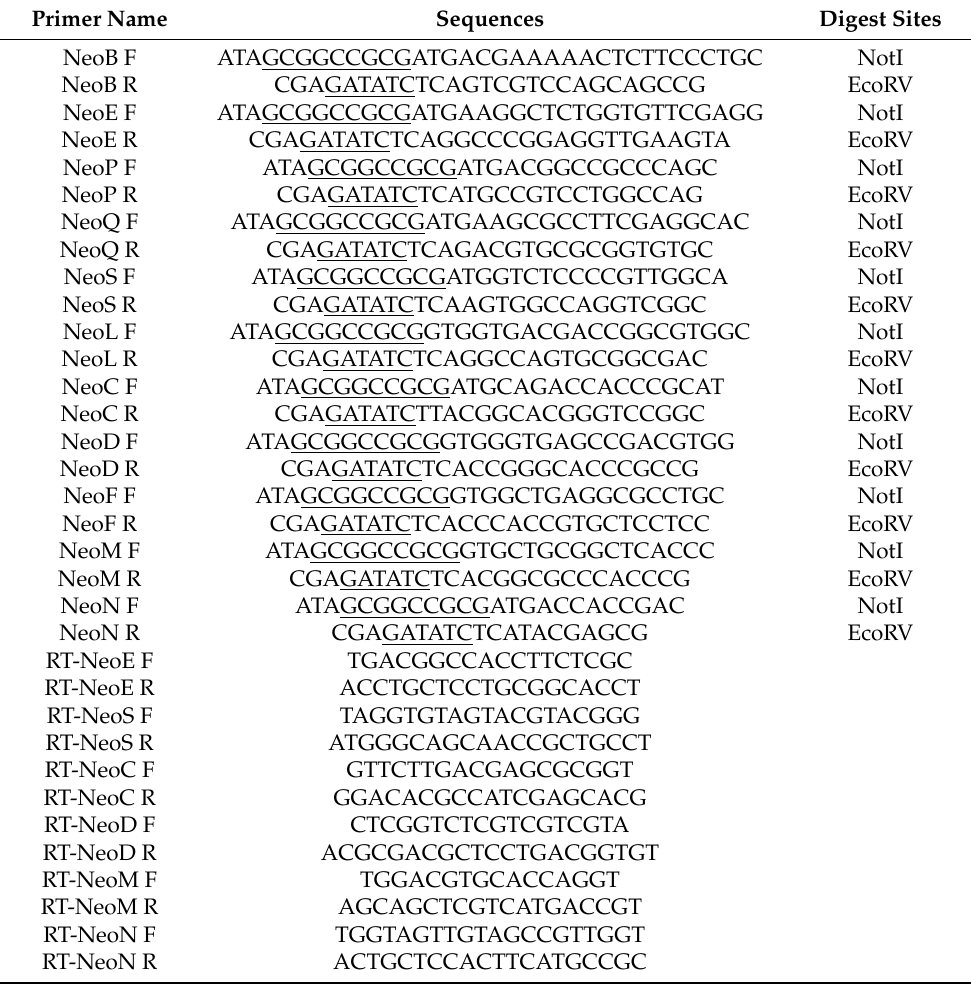
Table 2. Primers used in this